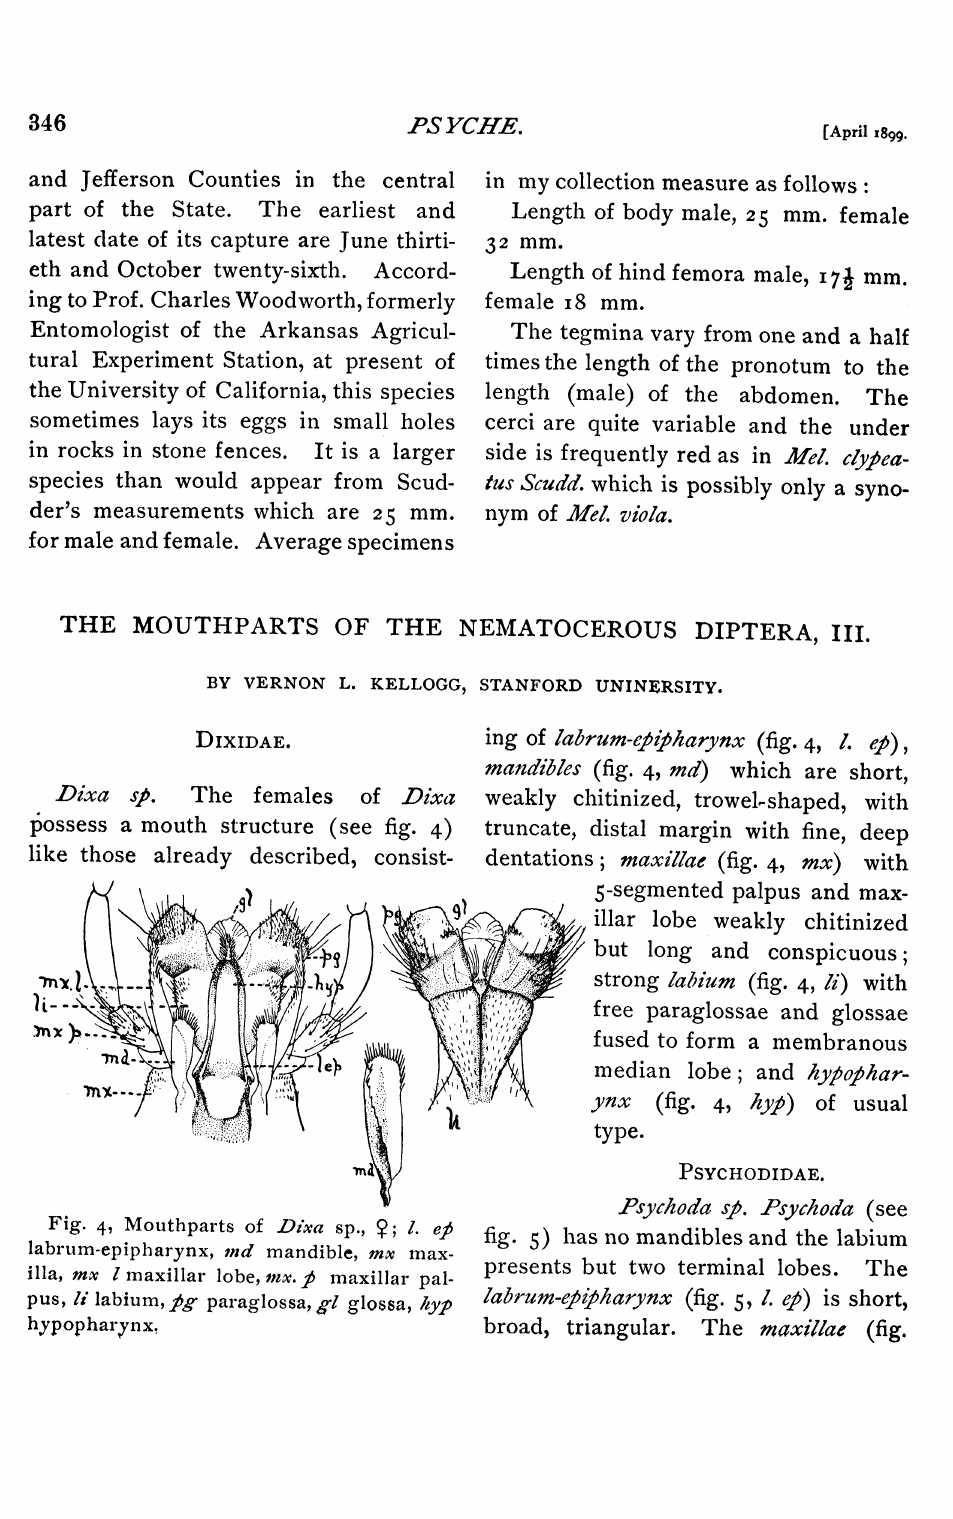
Fig. 4, Mouthparts of .Dixa